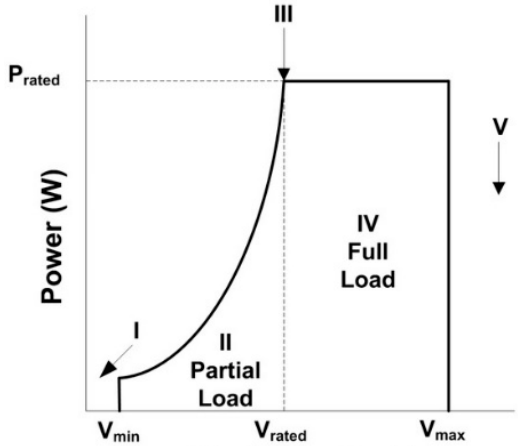
Figure 2. Tidal turbine modes of operation [24]. Table 1. Tidal turbine modes of operation [21].